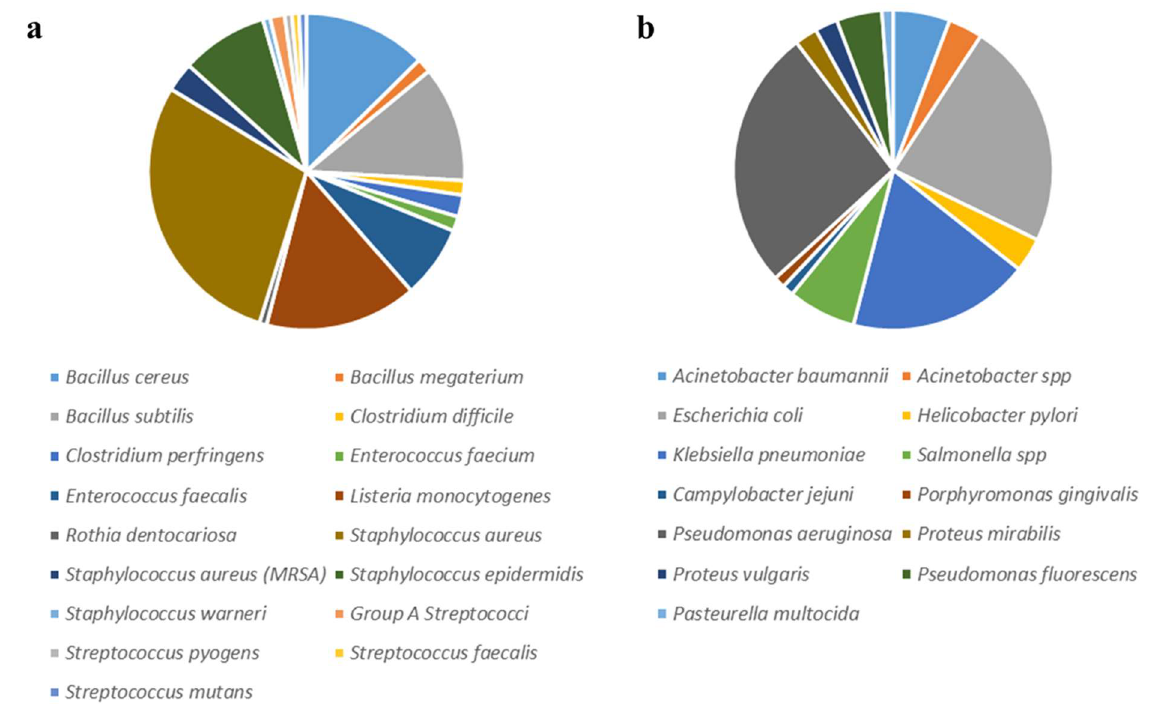
Figure 1. Pie chart showing the percentage of plants active against Gram+ ( a ) and Gram− ( b ). Table 1. Plants active against Gram+